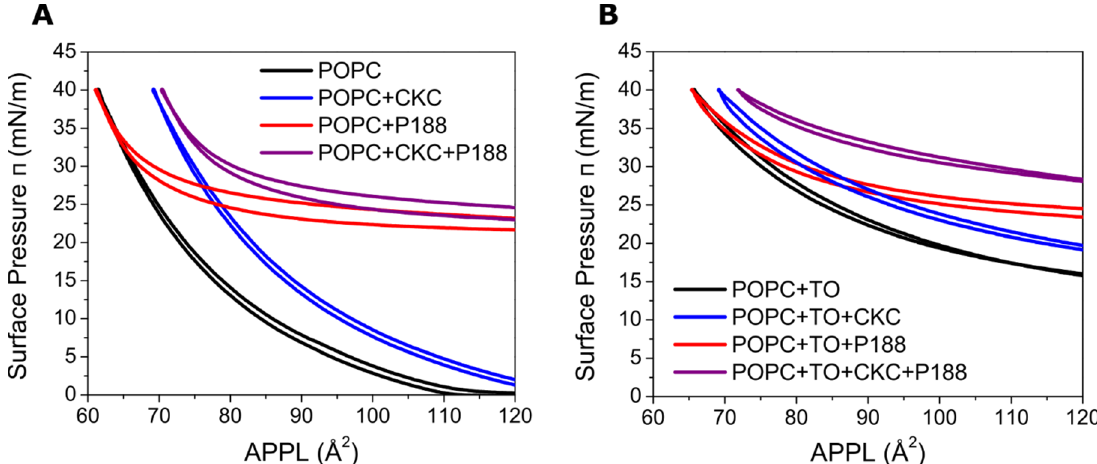
Figure 5. Surface pressure–area per polar lipid (APPL) isotherms of 1-palmitoyl-2-oleyl-sn-glycero-3-phosphocholine (POPC) ( A ) and POPC + triolein (TO) ( B ) films measured over pure subphase (black) and subphase containing P188 (red), CKC (blue), and the mix of P188 and CKC (violet).